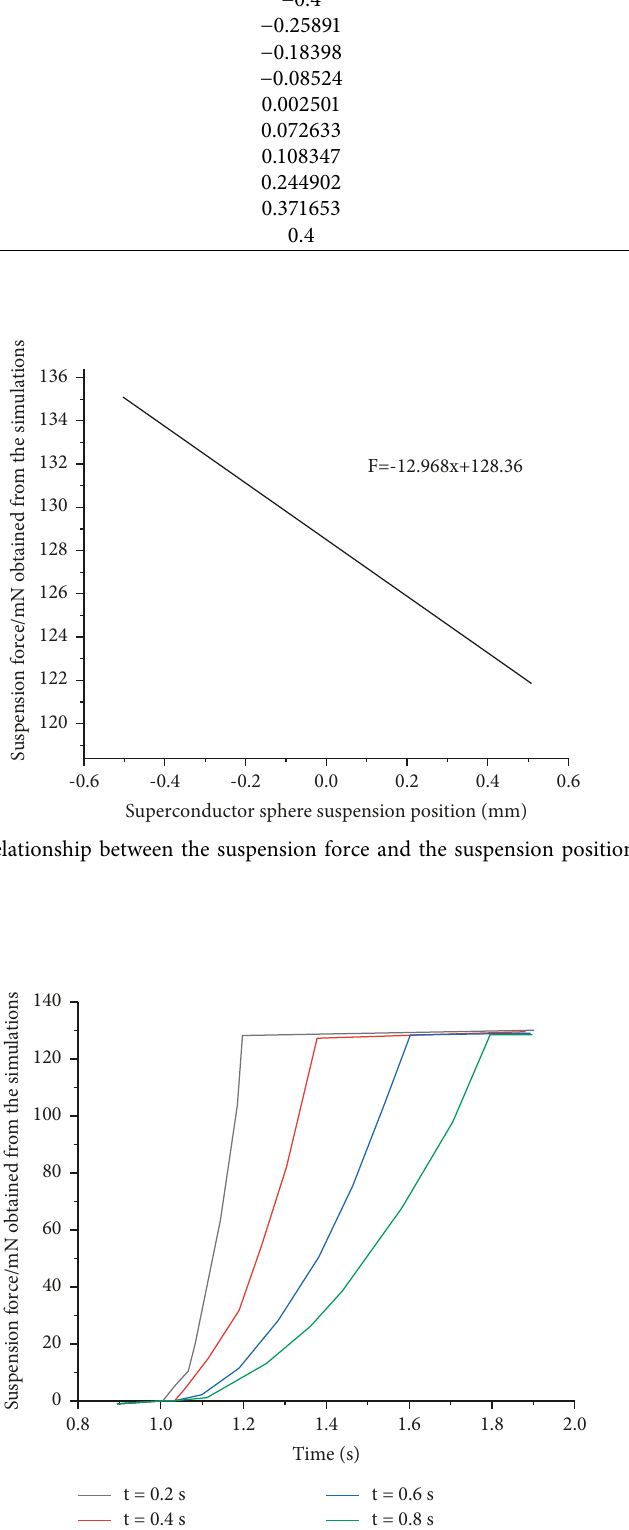
Figure 3: Levitation force obtained by applying current at different